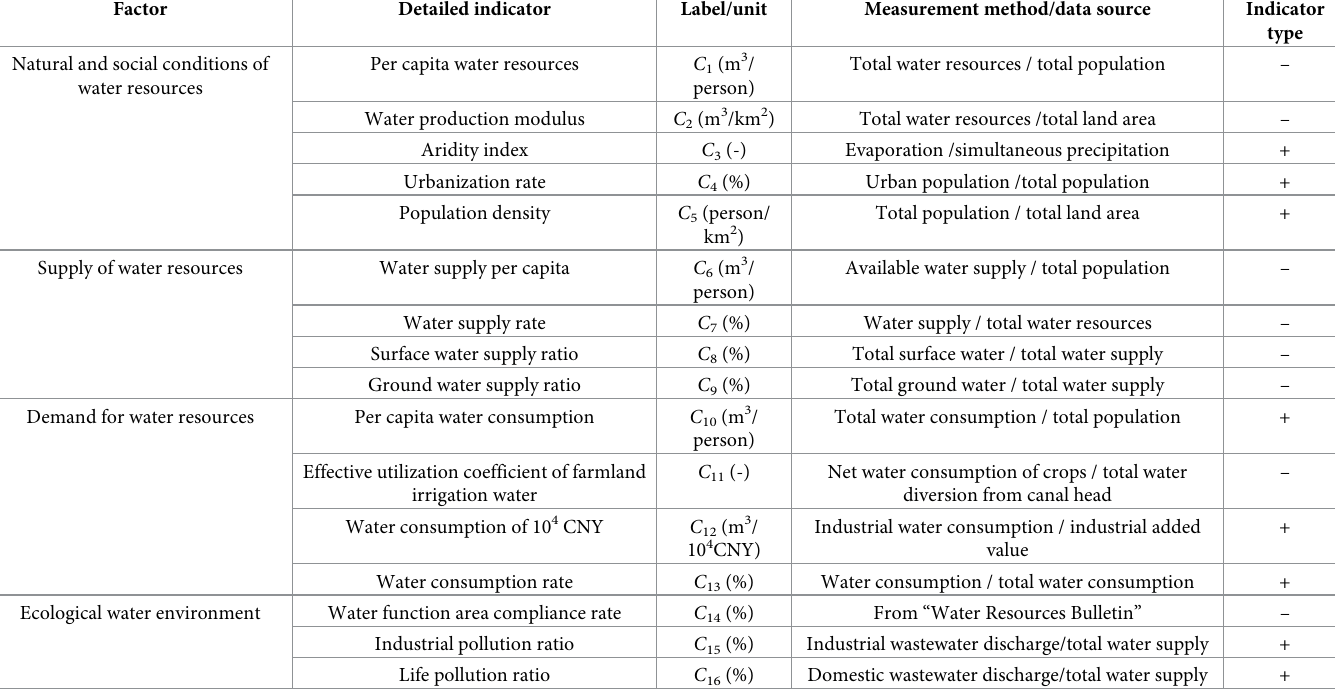
Table 1. Index system of transferor’s water shortage